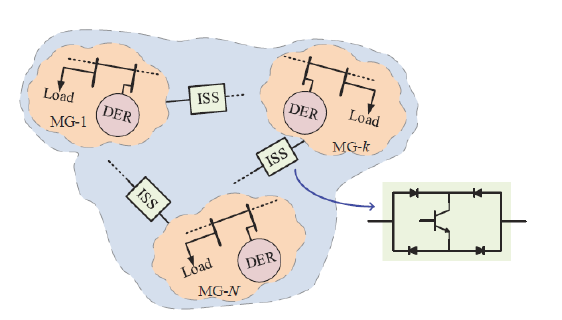
Figure 2. Connection of MGs with ISS